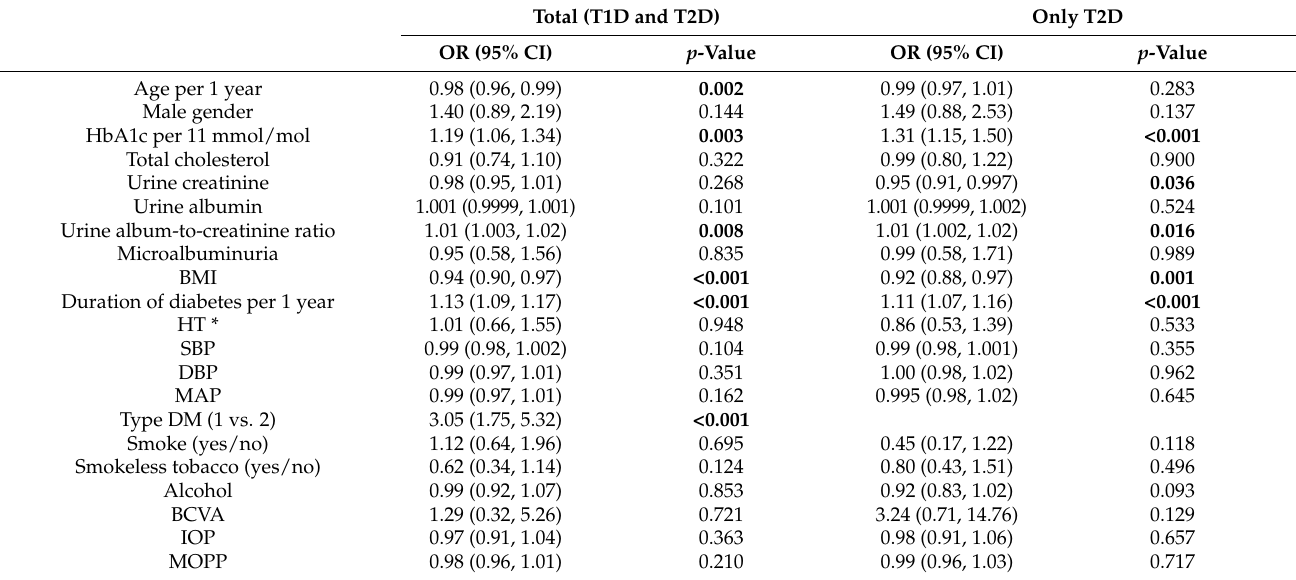
Table 4. Univariate analyses of the different parameters of the studied population. Total (T1D and